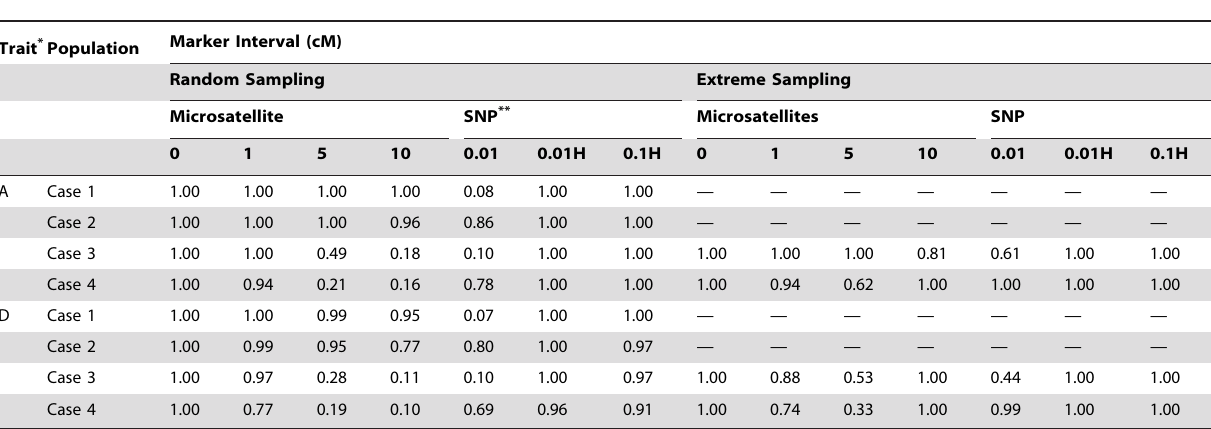
Table 2. Power in various samplings for a trait locus with 50% heritability.